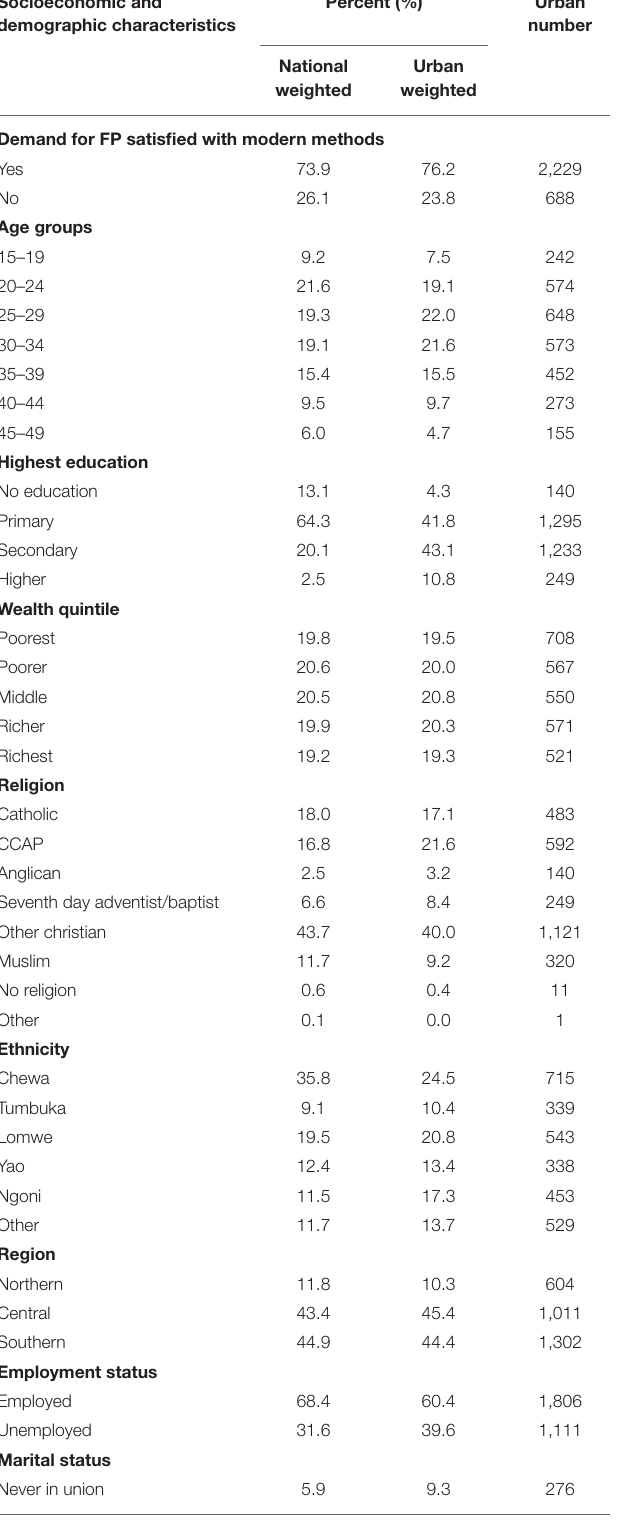
TABLE 1 | Socio-demographic characteristics of women with demand for FP in Malawi. Socioeconomic and demographic characteristics